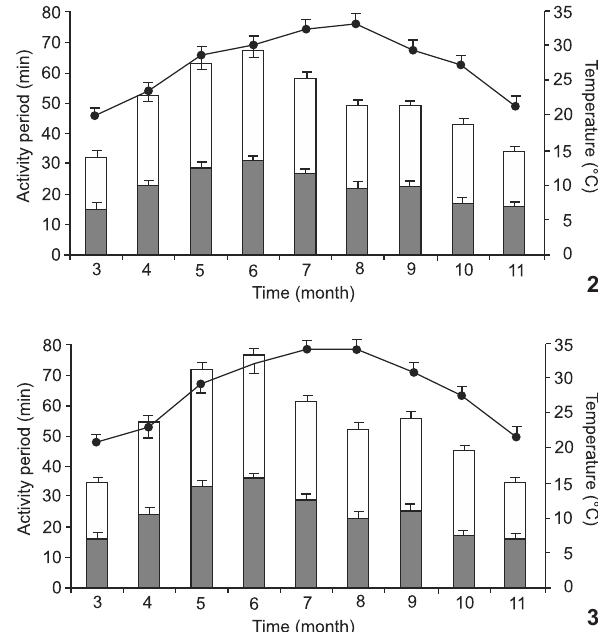
Figure 2-3. The total foraging time over one night (average value of seven nights for each month) of Tylonycteris pachypus in Longzhou County (2) and Guiping County (3). Solid portions in- dicate dusk foraging periods while hollow portions indicate dawn foraging periods. The dots indicate the average temperature.